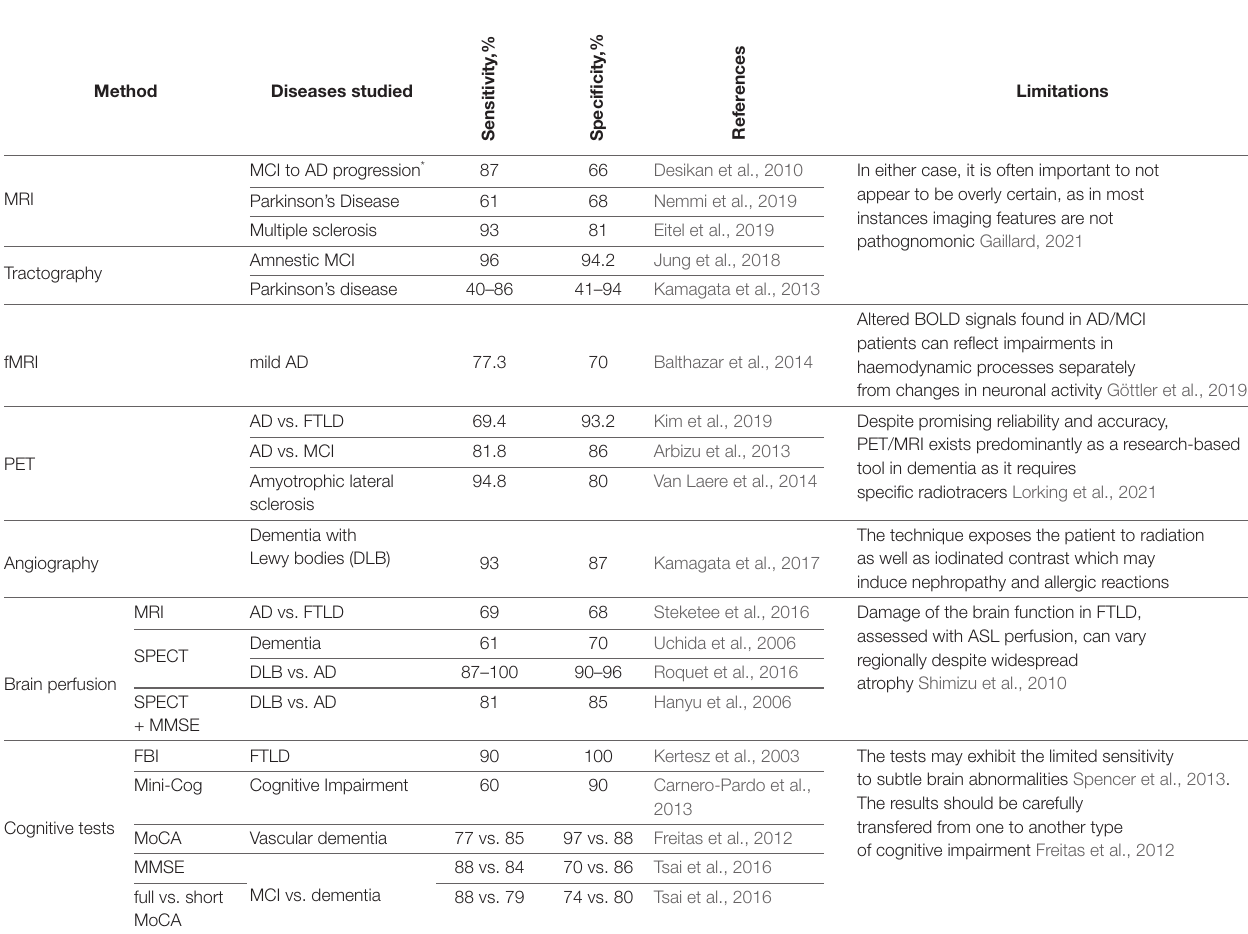
TABLE 1 | Accuracy and limitation of methods of diagnosing